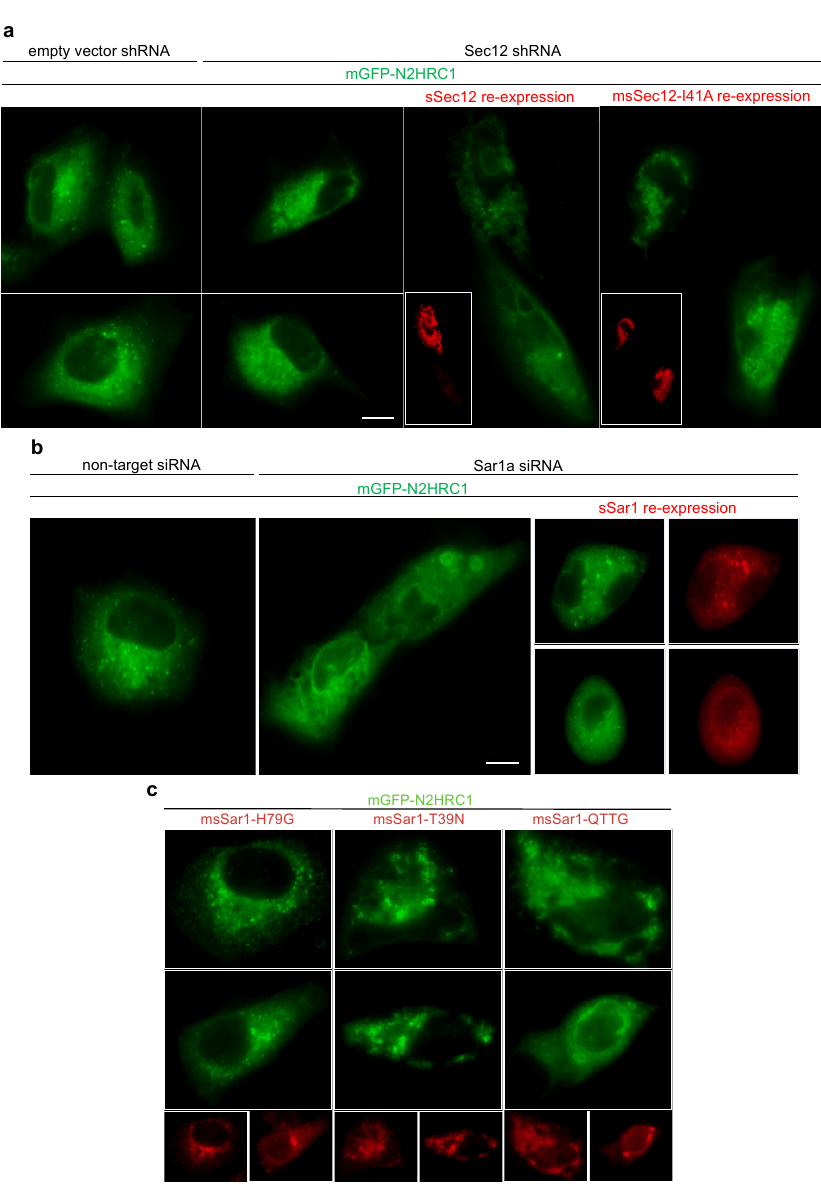
Figure 6. The fluorescence patterns of mGFP-N2HRC1 in A549 cells were examined under different conditions. ( a ) mGFP-N2HRC1 was expressed in A549 cells, constitutively expressing control shRNA or Sec12 shRNA. It showed a reticular pattern with punctae for pLAS2w.Ppuro (empty vector) cell lines, while the punctae significantly decreased in the Sec12 shRNA cell line (A0 cells). For the re-expression assay, the A0 cells were co-expressed with mGFP-N2HRC1 and sSec12 (wild type or I41A). The sSec12 proteins were identified using an anti-FLAG mouse antibody (red). ( b ) A549 cells were treated with siRNA (non-target; targeting Sar1), followed by mGFP-N2HRC1 expression. For the re-expression assay, sSar1 and mGFP-N2HRC1 were co-expressed after Sar1 knockdown and IFA identified recombinant Sar1, as above. Scale bar, 10 µ m. ( c ) A549 cells were co-transfected for mGFP-N2HRC1 and dominant-negative msSar1 (mutated sSar1), which was labeled with anti-FLAG antibodies (red).